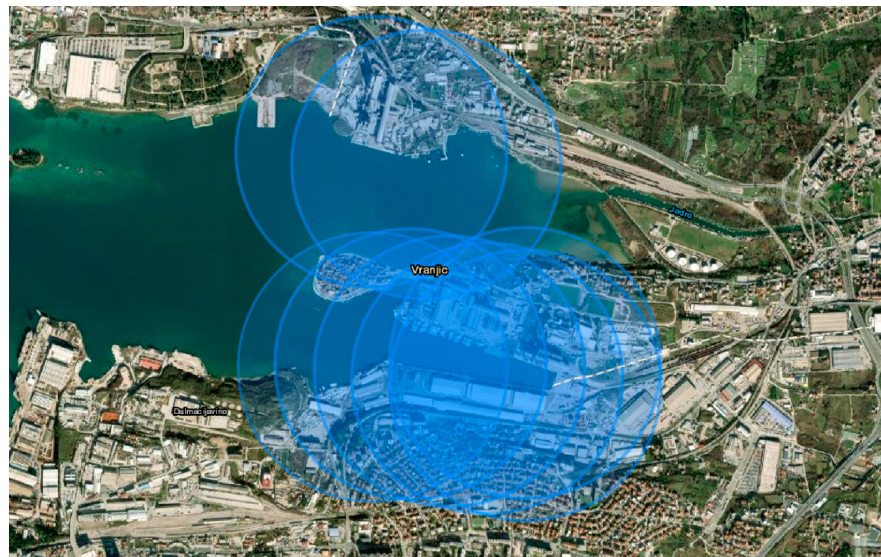
Figure 8. Simulation of Scenario 1 ([46], modified).